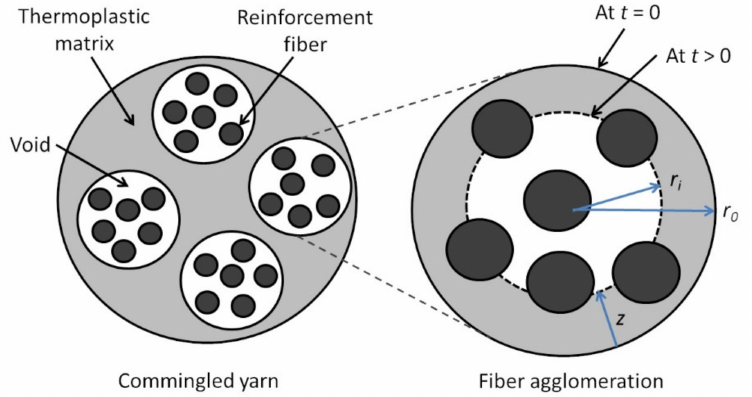
Figure 7. Cross section of commingled yarn modeled as a group of fiber